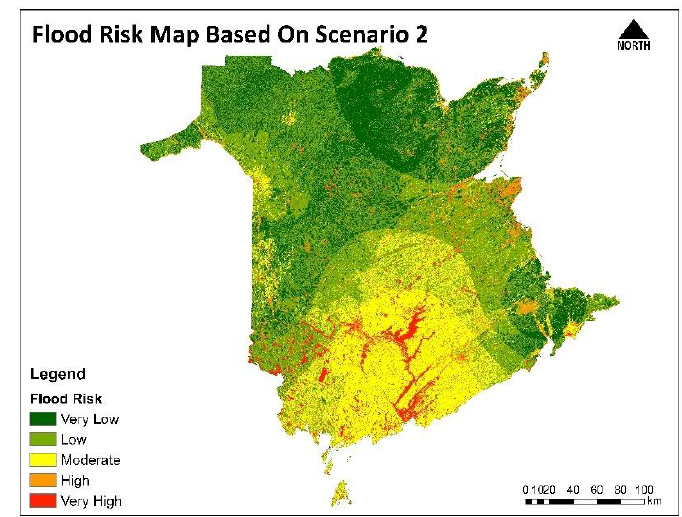
Figure A17. Flood Risk Map Based on Scenario 1.